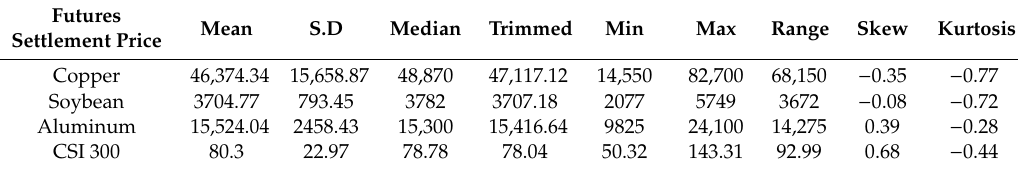
Table 1. Summary statistics of daily futures settlement price.